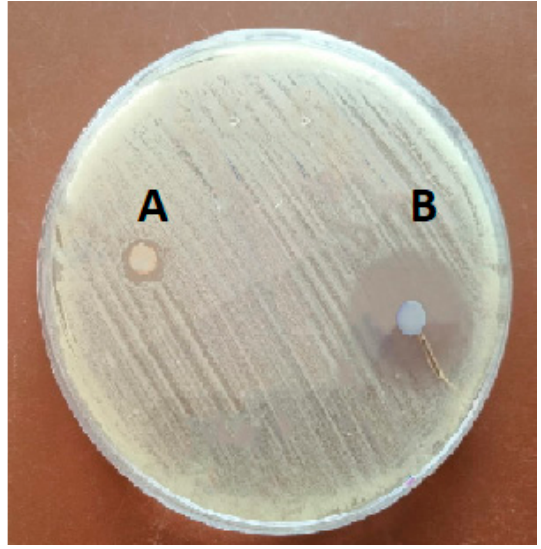
Figure 1. Inhibition zone of chitosan against S. agalactia ( A ) and CWPNC ( B ). Table 2. The inhibition zone, MIC, and MBC of CWPNC and chitosan against S. agalactiae.